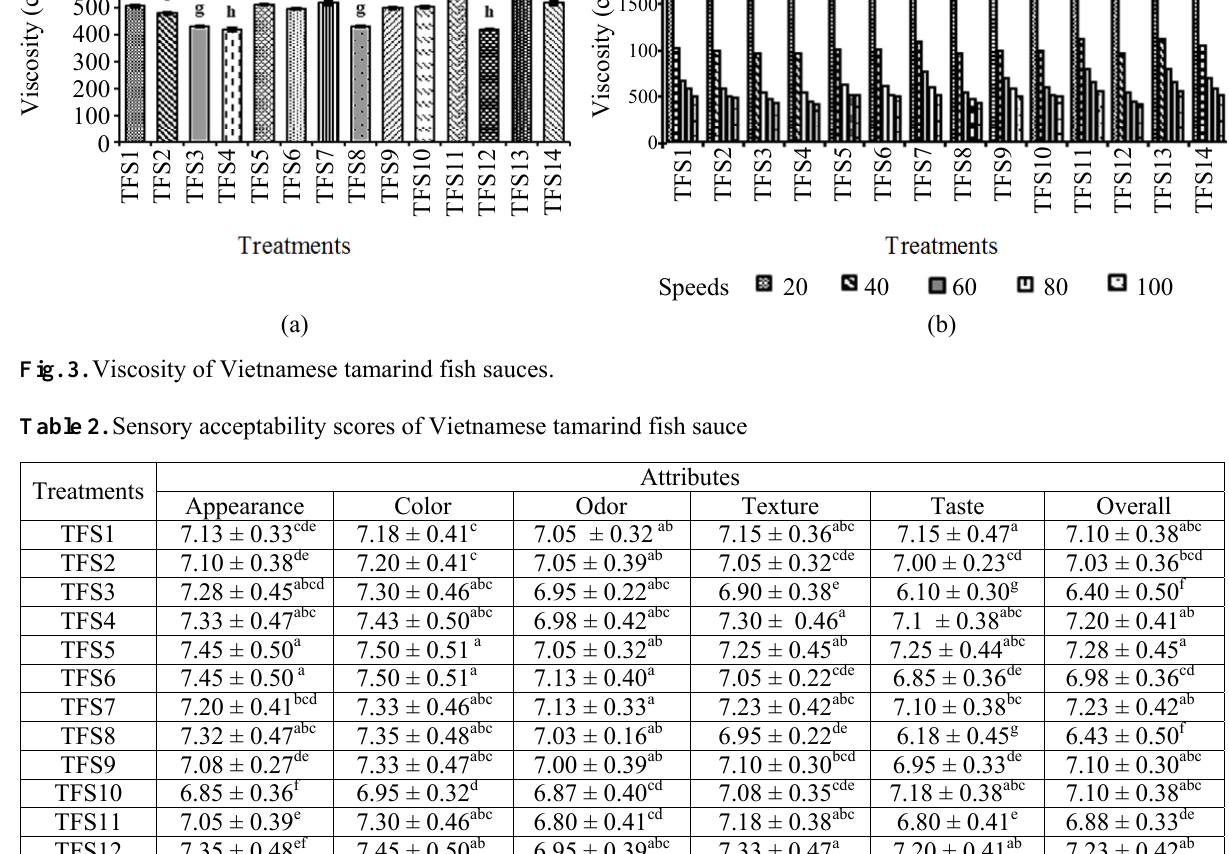
Table 3. Levels of iron, zinc and vitamin A fortification of Vietnamese tamarind fish sauce Treatments